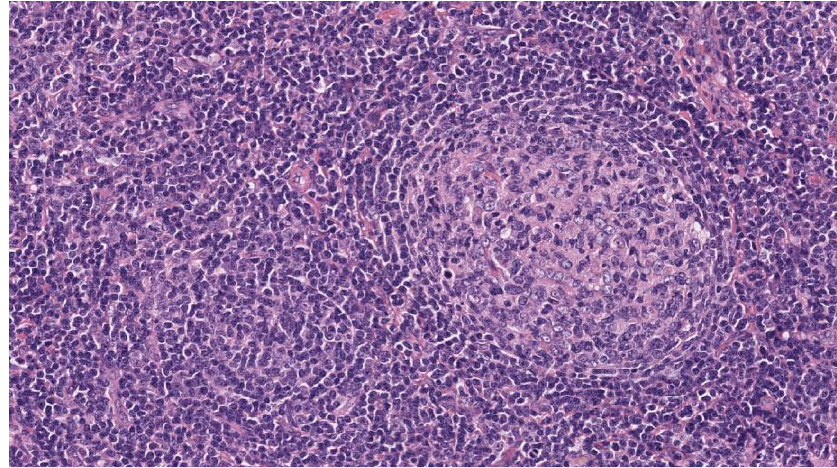
Figure 1. H&E original magnification 20x. The lymph node architecture is replaced by a diffuse, interfollicular monotonous proliferation of small lymphocytes with round nuclei and scant cytoplasm surrounding hyperplastic follicles with regularly structured germinal centers.